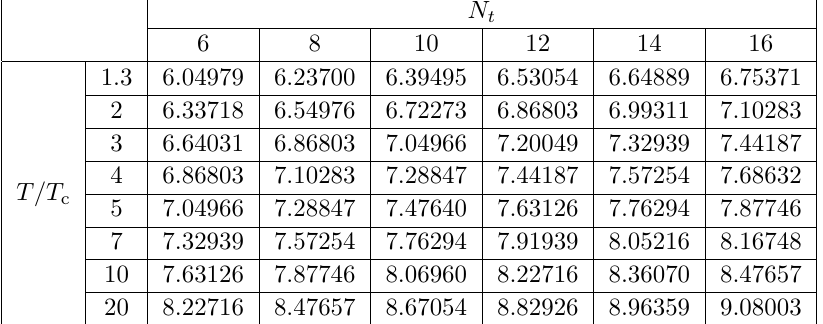
Value of the lattice coupling β latt for different values of T/T c (where T c is the critical temperature of the pure-glue Yang-Mills theory, given by T c = 287 . 4(70) MeV) and number of sites in the temporal direction N t